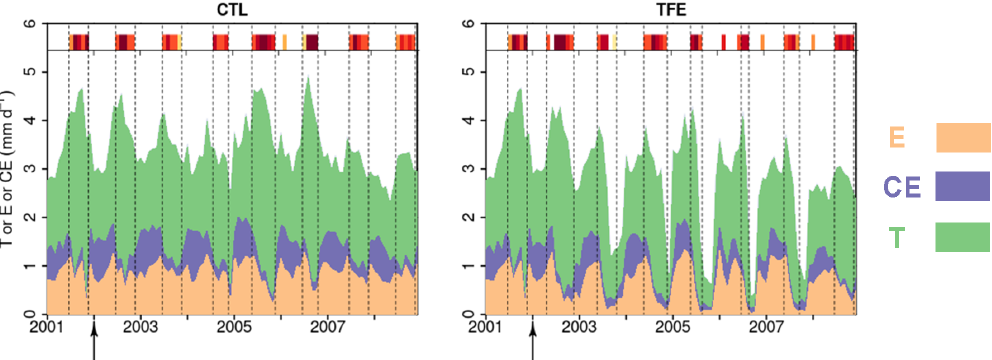
Figure 3. Modeled (ORCHIDEE-CAN-NHA) daily soil evaporation ( E ), canopy evaporation (CE) and transpiration ( T ) during 2001–2008. The arrows point to the start of TFE at the beginning of 2002. The inserted shaded red bars denote the periods with water deficits during the simulation period, following the same color scale as Fig.